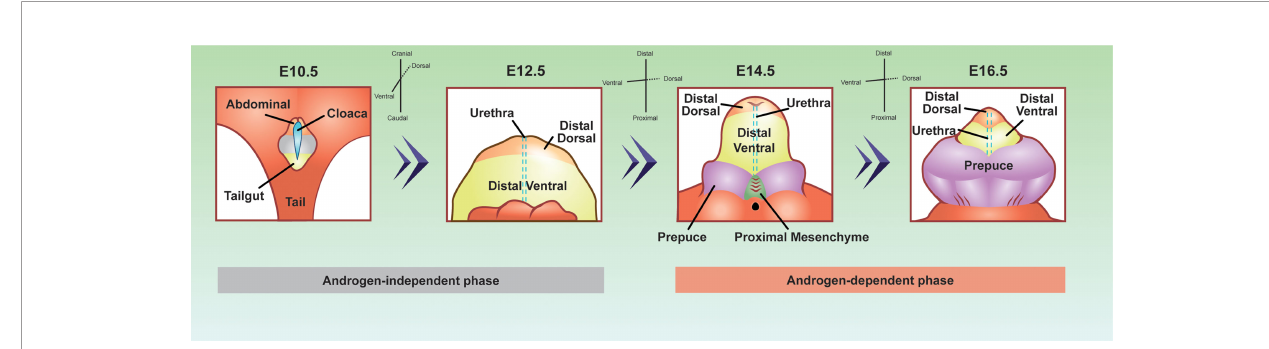
FIGURE 2 | Developmental origins of the penis cell populations in the embryonic mouse penis. The colors represent conserved cell populations through time. Blue=cloacal/urethra epithelium, yellow=tailgut/distal ventral glanular mesenchyme, light orange=abdominal/distal dorsal glanular mesenchyme, purple=prepuce, green=proximal glanular mesenchyme, and grey= unde fi ned penile cell population. The E10.5 depiction is looking at the lower half of the embryo, while the other time points are focused on the genitalia. E10.5 depiction was adapted and redrawn from (64). E12.5, 14.5, and 16.5 were adapted from whole mount, scanning electron microscope images from